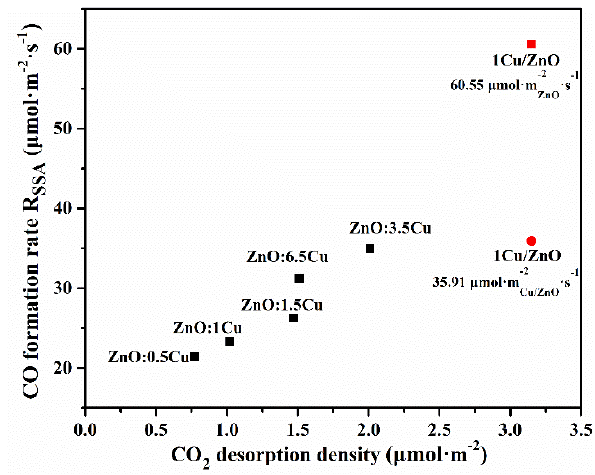
Figure 8. The relationship between CO formation rate R SSA and CO 2 desorption density from peak ( β 1 + β 2 ) at 450 °C.